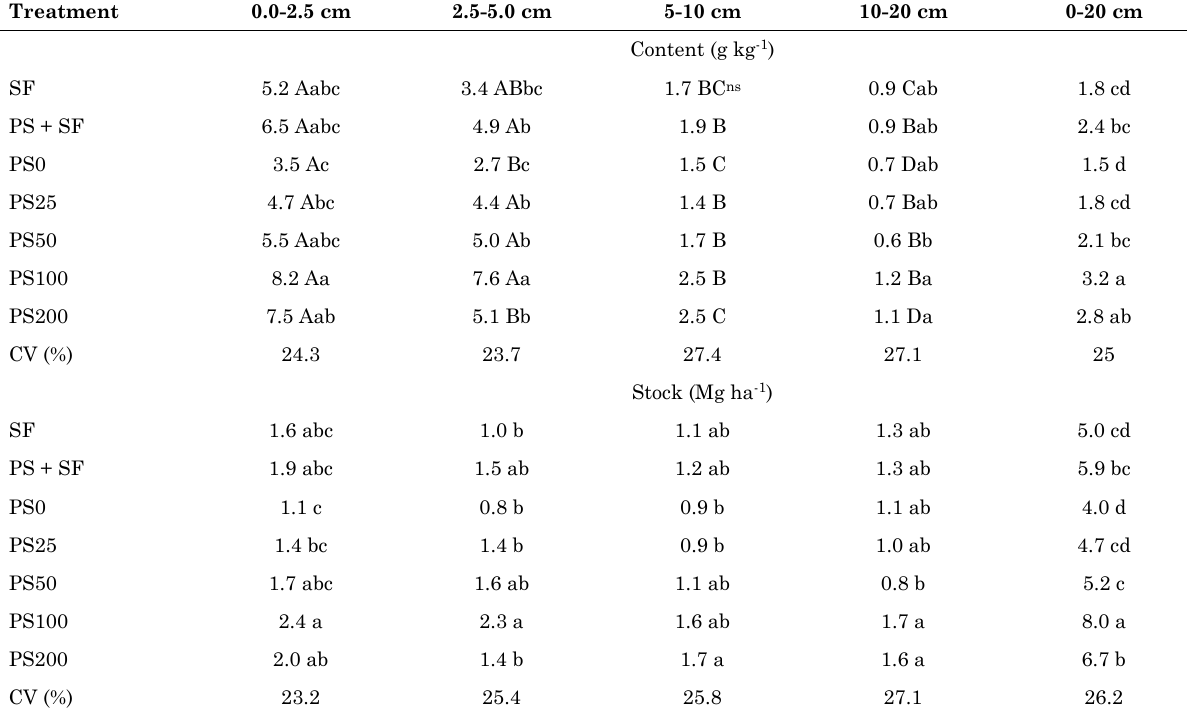
Table 3. Contents and stocks as particulate organic carbon (POC), with size >53 μm in layers 0.0-2.5, 2.5-5.0, 5-10, 10-20 and 0-20 cm of a typic Hapludox cultivated for nine years with no-tillage maize and oat and annually fertilized with soluble fertilizer (sF), pig slurry (Ps) at rates up to 200 m 3 ha -1 and combined Ps + sF. Mean of four replications